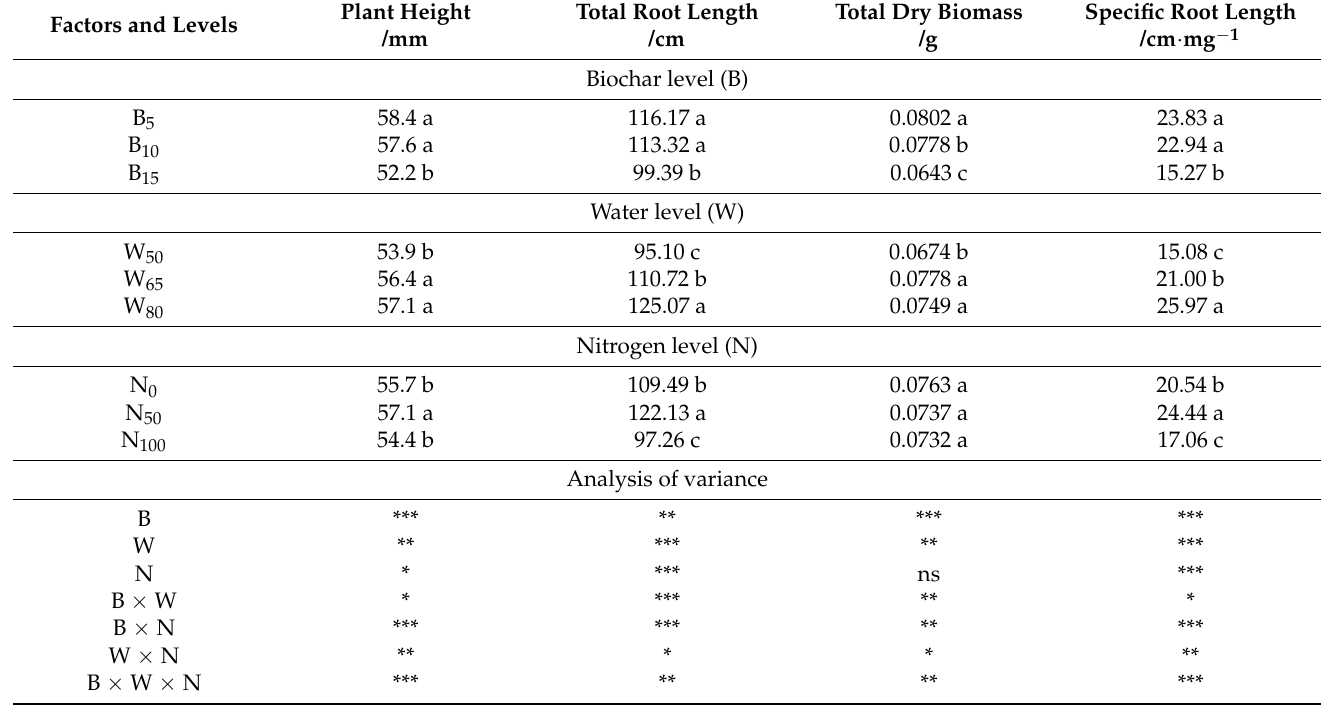
Table 1. Plant height, total root length, total dry biomass, and specific root length of cucumber